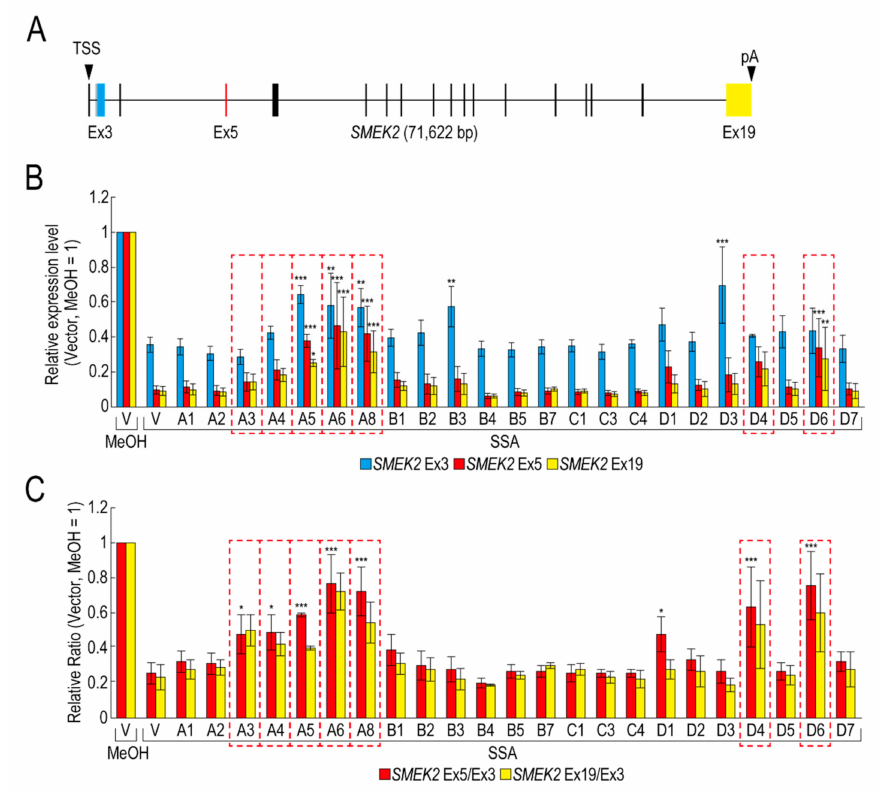
Figure 1. RNA binding proteins (RBPs) reduce the transcription elongation defect caused by splicing deficiency. ( A ) Schematic representation of the SMEK2 gene. Black arrowheads indicate the transcription start site and the polyA site. Cyan, red, and yellow rectangles are Ex3, Ex5, and Ex19, respectively. ( B , C ) HeLa cells were transfected with a vector (V) or the indicated RBP in our library, and then cultured for 48 h after transfection. The cells were treated with MeOH or spliceostatin A (SSA) (10 ng / mL) for 1 h, and then treated with 200 µ M 5-EU for an additional 2 h to label nascent RNA. The labeled RNA was analysed by quantitative RT-PCR. Relative expression levels of SMEK2 Ex3, Ex5, and Ex19 were plotted ( B ). Ratios of the expression levels of Ex5 or Ex19 relative to that of Ex3 (i.e., Ex5 / Ex3 and Ex19 / Ex3, respectively) were plotted ( C ). Error bars indicate S.D. ( n = 3). Statistical significance was investigated by one-way ANOVA and Dunnett’s test (*: p < 0.05; **: p < 0.01; ***: p < 0.001). Red dotted line rectangles indicate RBPs that suppressed the transcription elongation